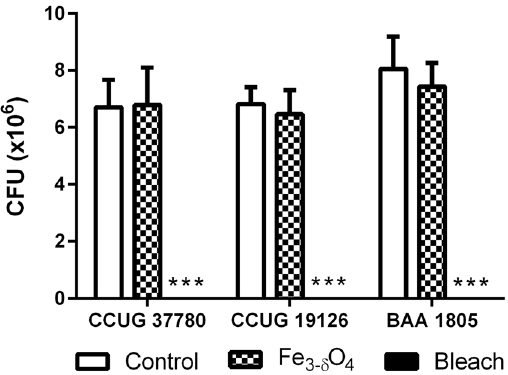
Figure 4. The viability of C . difficile vegetative cells was not significantly affected by Fe 3- δ O 4 -treatment. Fe 3- δ O 4 nanoparticles (500 µ g/mL) did not inhibit the viability of vegetative C . difficile in all three test strains compared cells treated with 3% sodium hypochlorite. ( *** P < 0.001; Student’s t